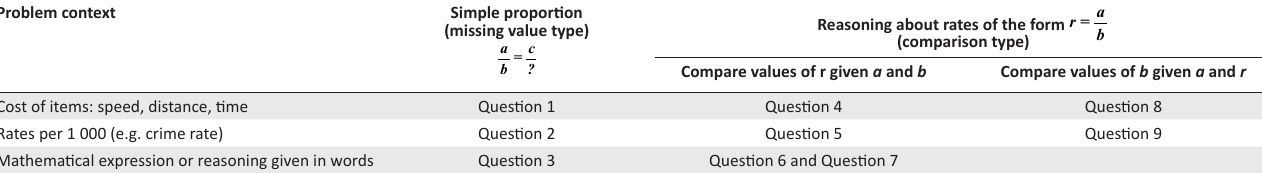
TABLE 1: Summary of the characteristics of the proportional reasoning questions. Problem